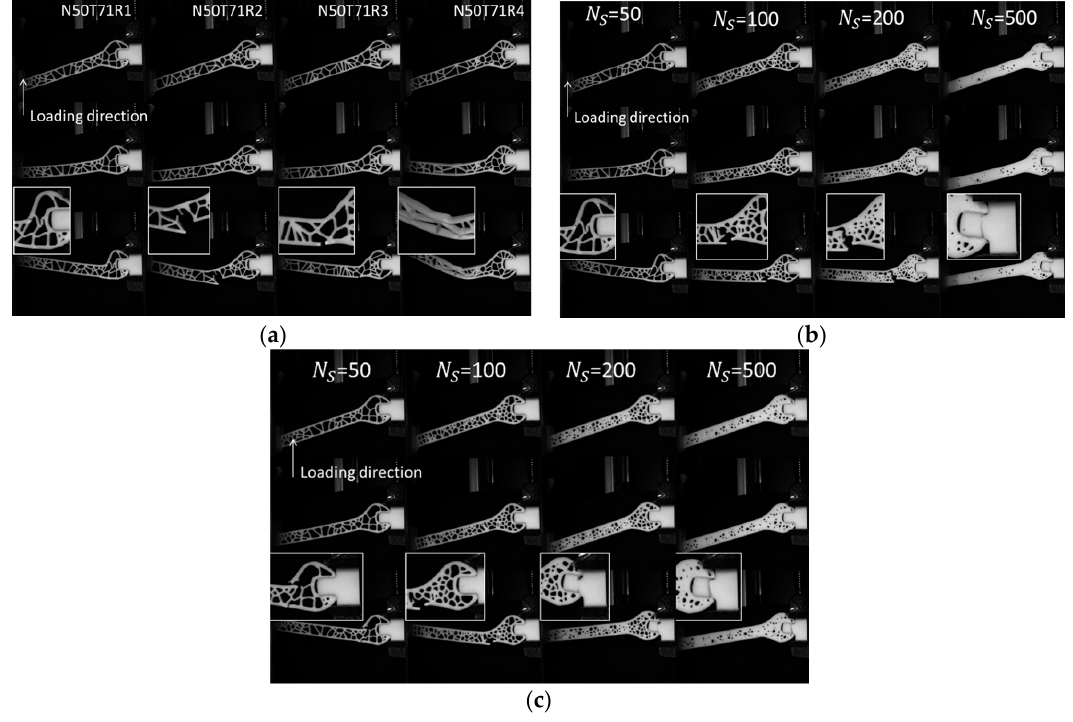
Figure 6. Deformation sequences of 3D printed cellular wrenches for ( a ) different replicates, ( b ) an increasing number of seed points ( t R = 71 MCS), and for ( c ) a large relaxation time ( t R = 100